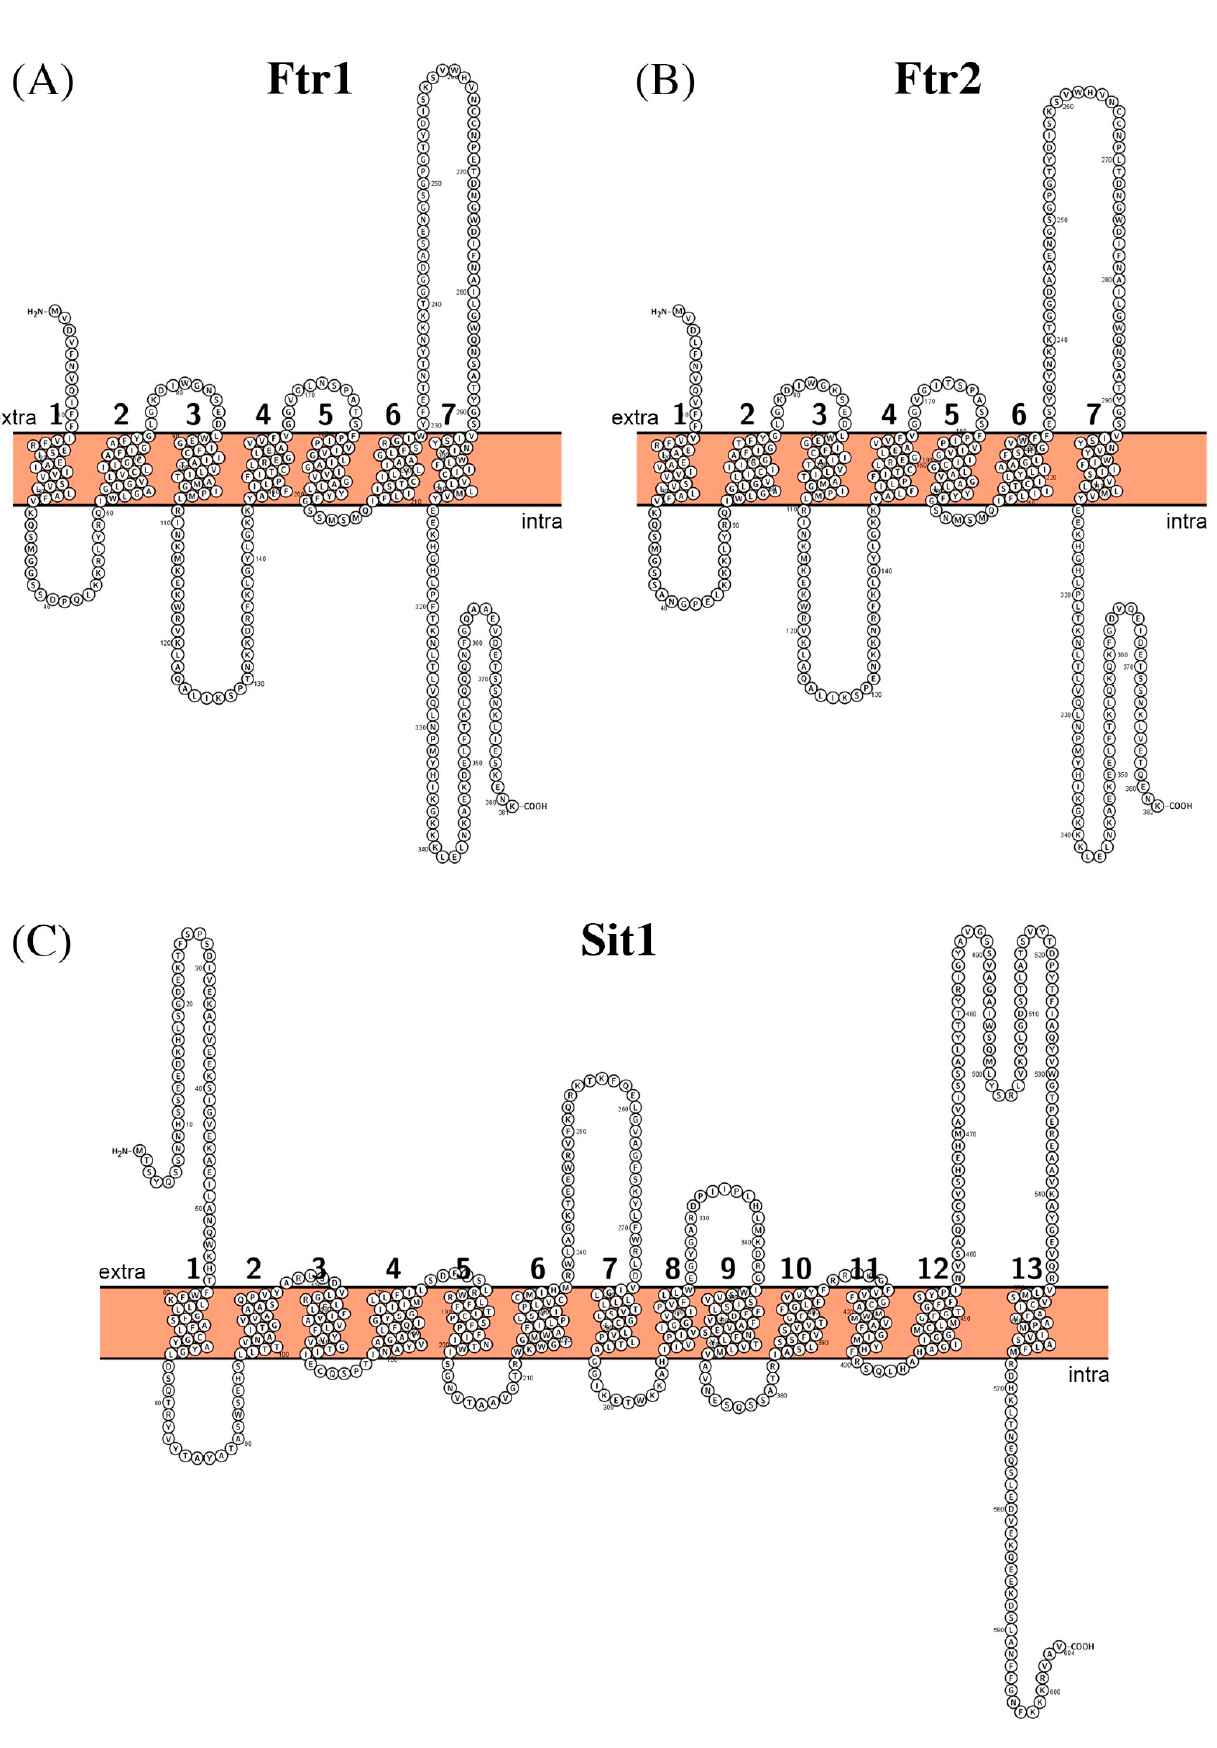
Figure 6. Schematic representation of the proposed secondary structure and topology of Ftr1 ( A ), Ftr2 ( B ), and Sit1 ( C